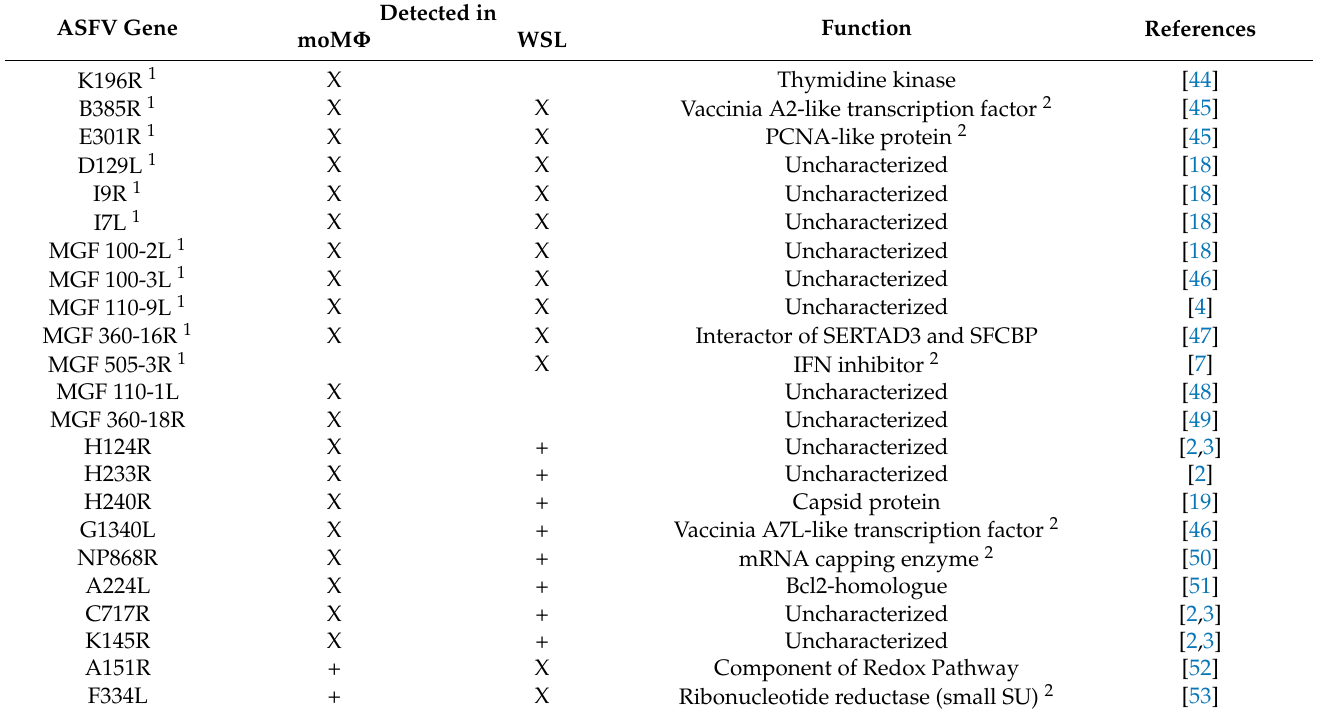
Table 1. Summary of viral genes that are differentially expressed in moM Φ and WSL cells or for which corresponding proteins have been identified for the first time. ASFV